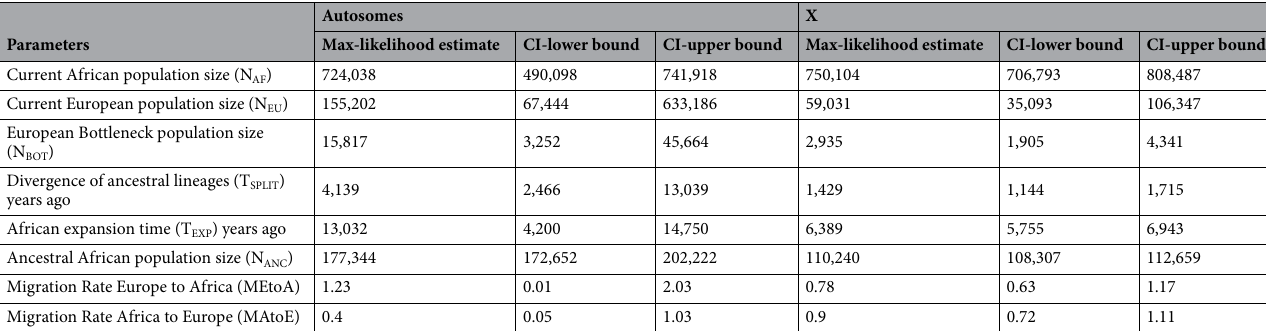
Table 1. Demographic estimates for the best model (ASYMIG). Demographic estimates obtained with dadi for our best model (ASYMIG) for autosomal ( 2R , 3L , 3R ) and X-linked. Estimates have been converted into years and population sizes assuming 15 generations per year and the mutation rate estimates of Huang et al. (2016). Migration rates are given in units of 2.N ANC. m ij, where i and j are the source and sink populations,